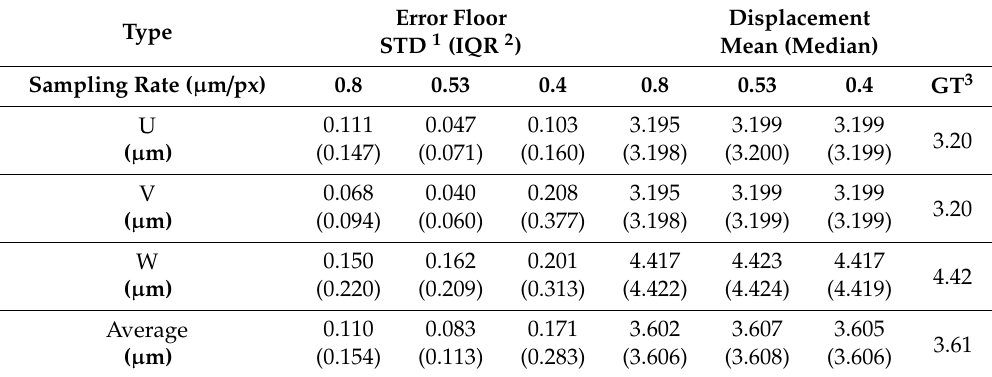
Table 1. Error floor and displacement of measured deformation for various sampling